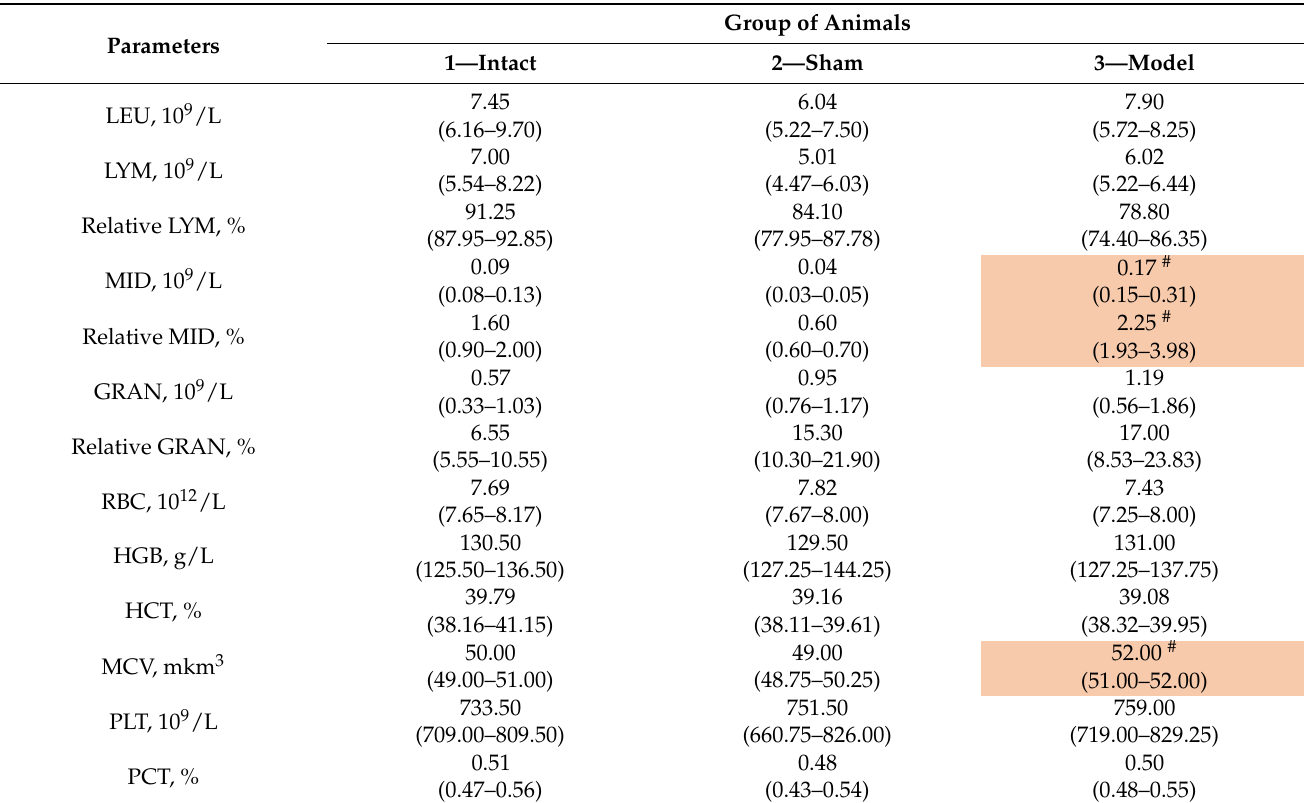
Table 5. Results of the animals’ blood hematological analysis at the end of the experiment. The results are presented as Me, (P 25 –P 75 ). In the table, colored cells allow to focus on the most important